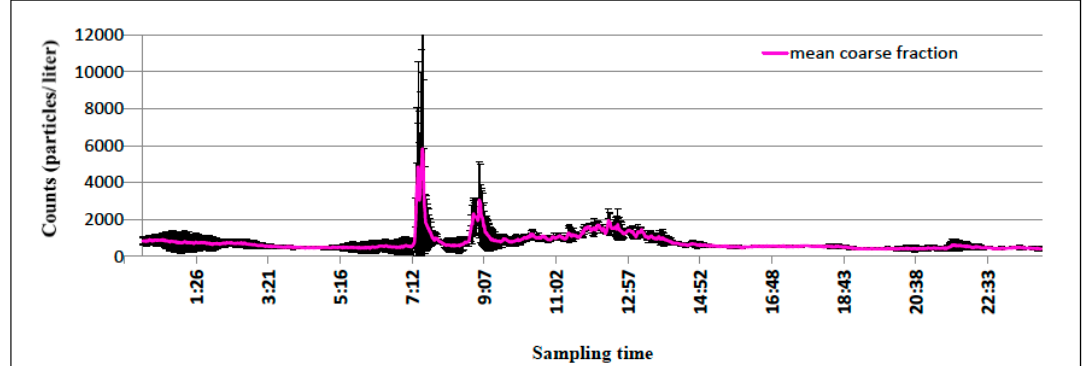
Figure 4. Coarse fraction ( > 1.10 µ m) mean obtained by considering all bakery nonworking days (Sundays) during sampling period.